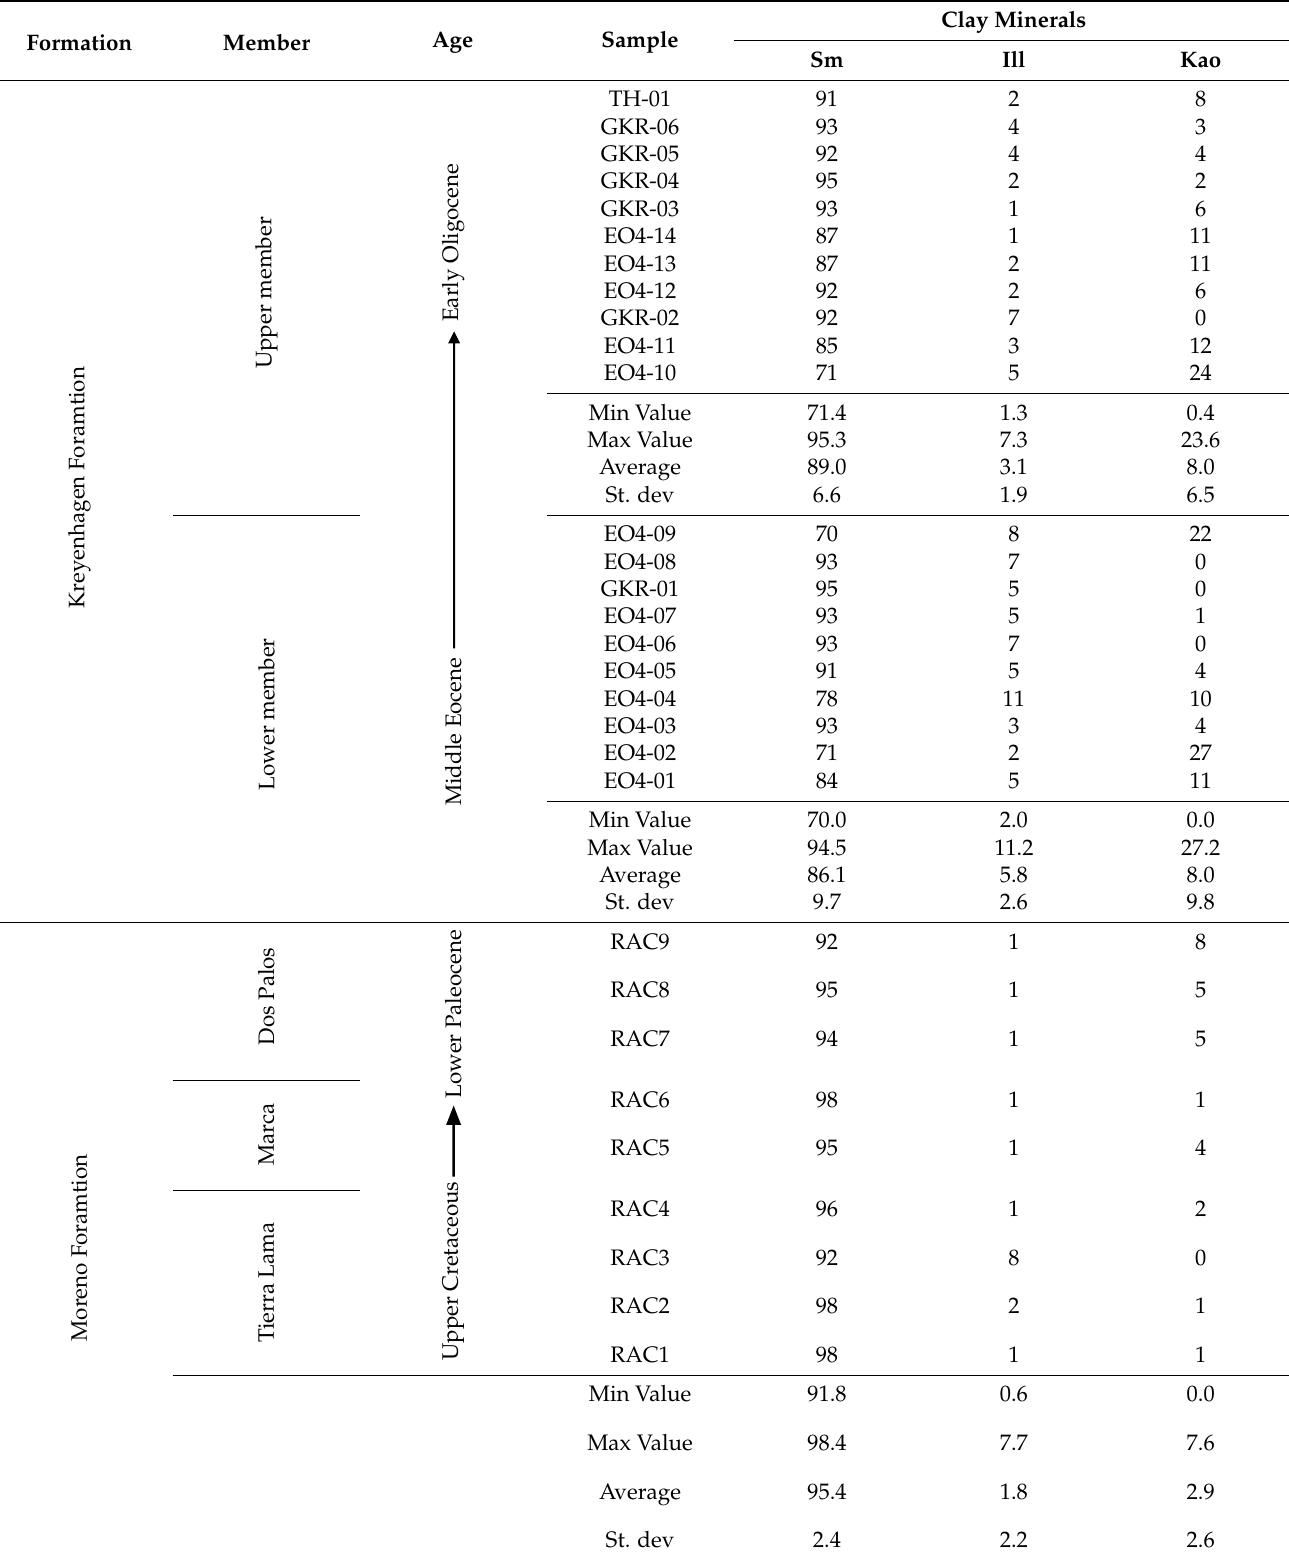
Table 3. Clay minerals (wt %) for Kreyenhagen and Moreno formations estimated from XRD analyses of the <2 µ m fractions. Abbreviations as in Table 1. Sample locations are in Figure 3. Table 2 . Major element chemistry for samples shown in Table 1. LOI = loss on ignition. CIA = chemical index of alteration [25].